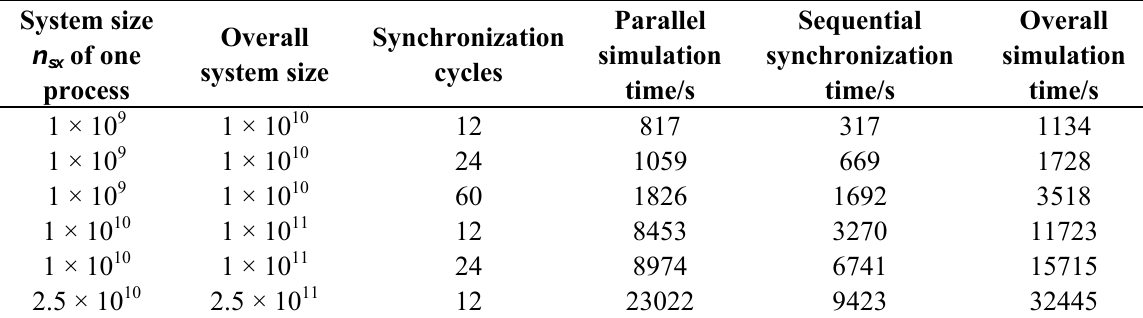
Table 11. Performance analysis in parallel environments (10 processes); Reaction time = 1 h; Linux-Opteron; [CDB] = 0.025 mol/L; [MA] , = 11.04 mol/L. 0 0